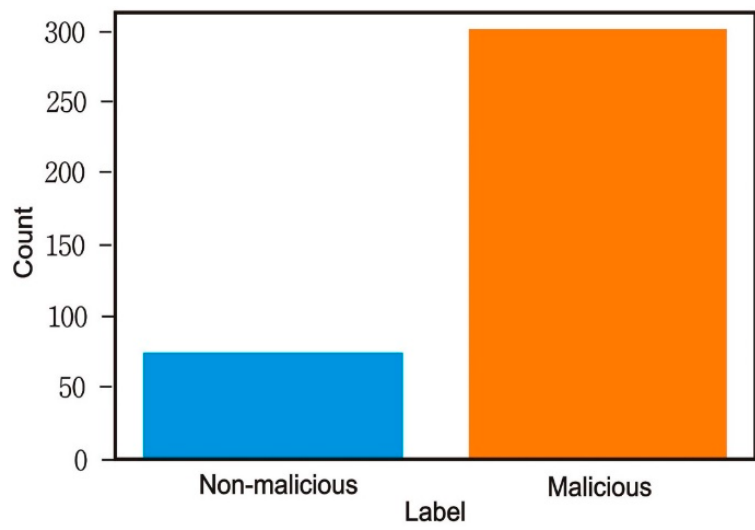
Figure 8. Counts of malicious and non-malicious data points after feature selection.